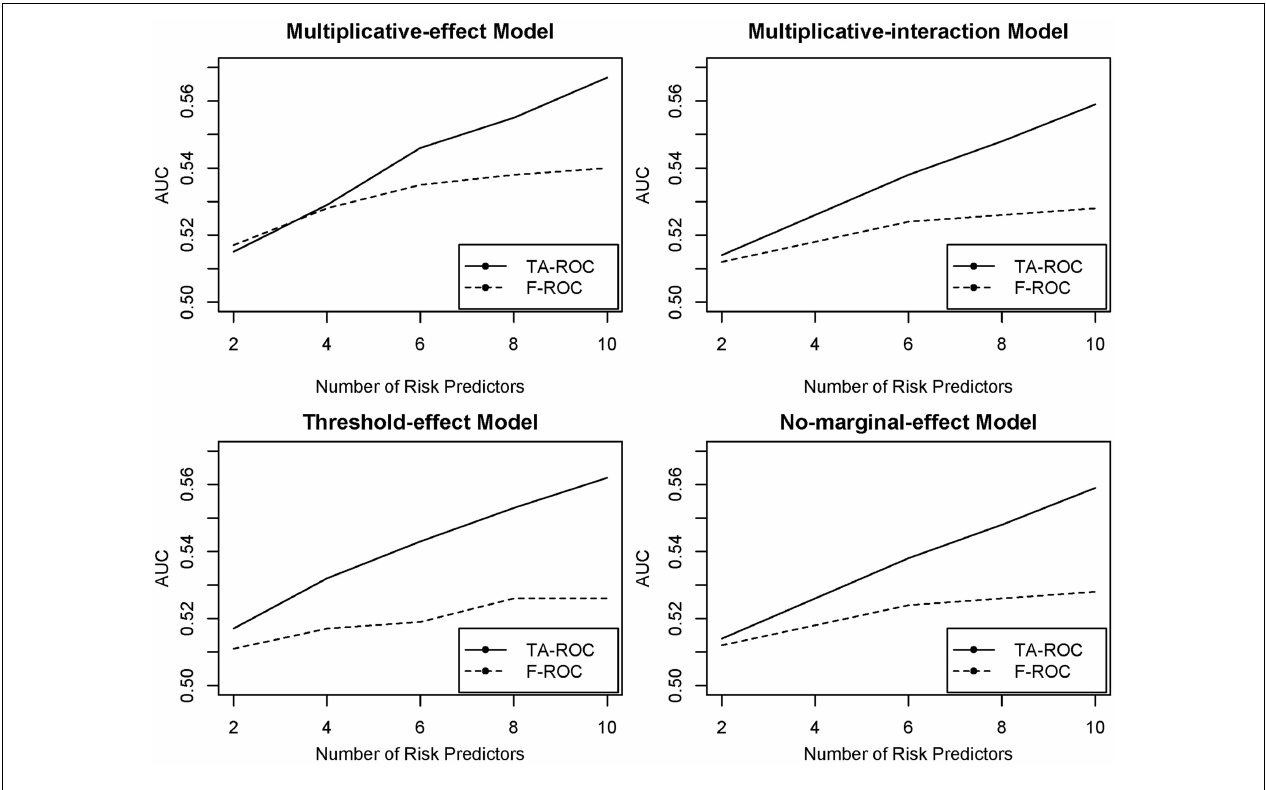
FIGURE 2 | Prediction performance ofTA-ROC and F-ROC on simulated data.